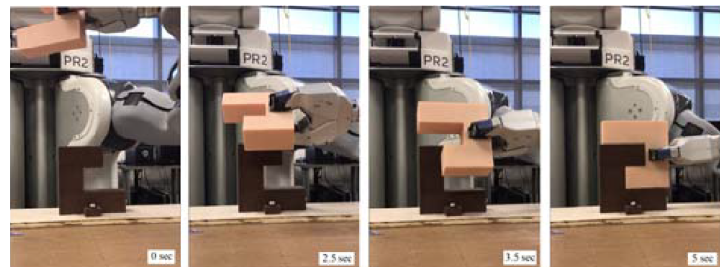
Figure 8. U shape object assembly [87].